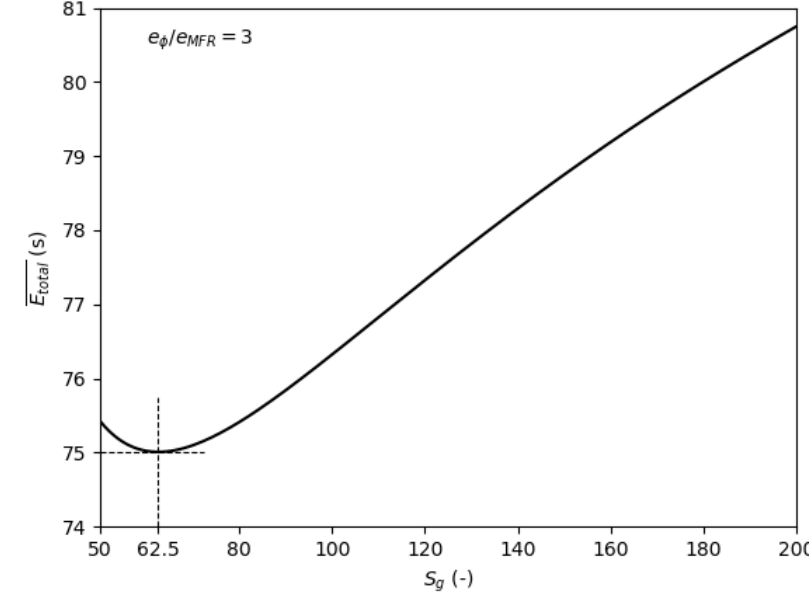
Figure 12. Integrated error evolution depending on the geometric swirl